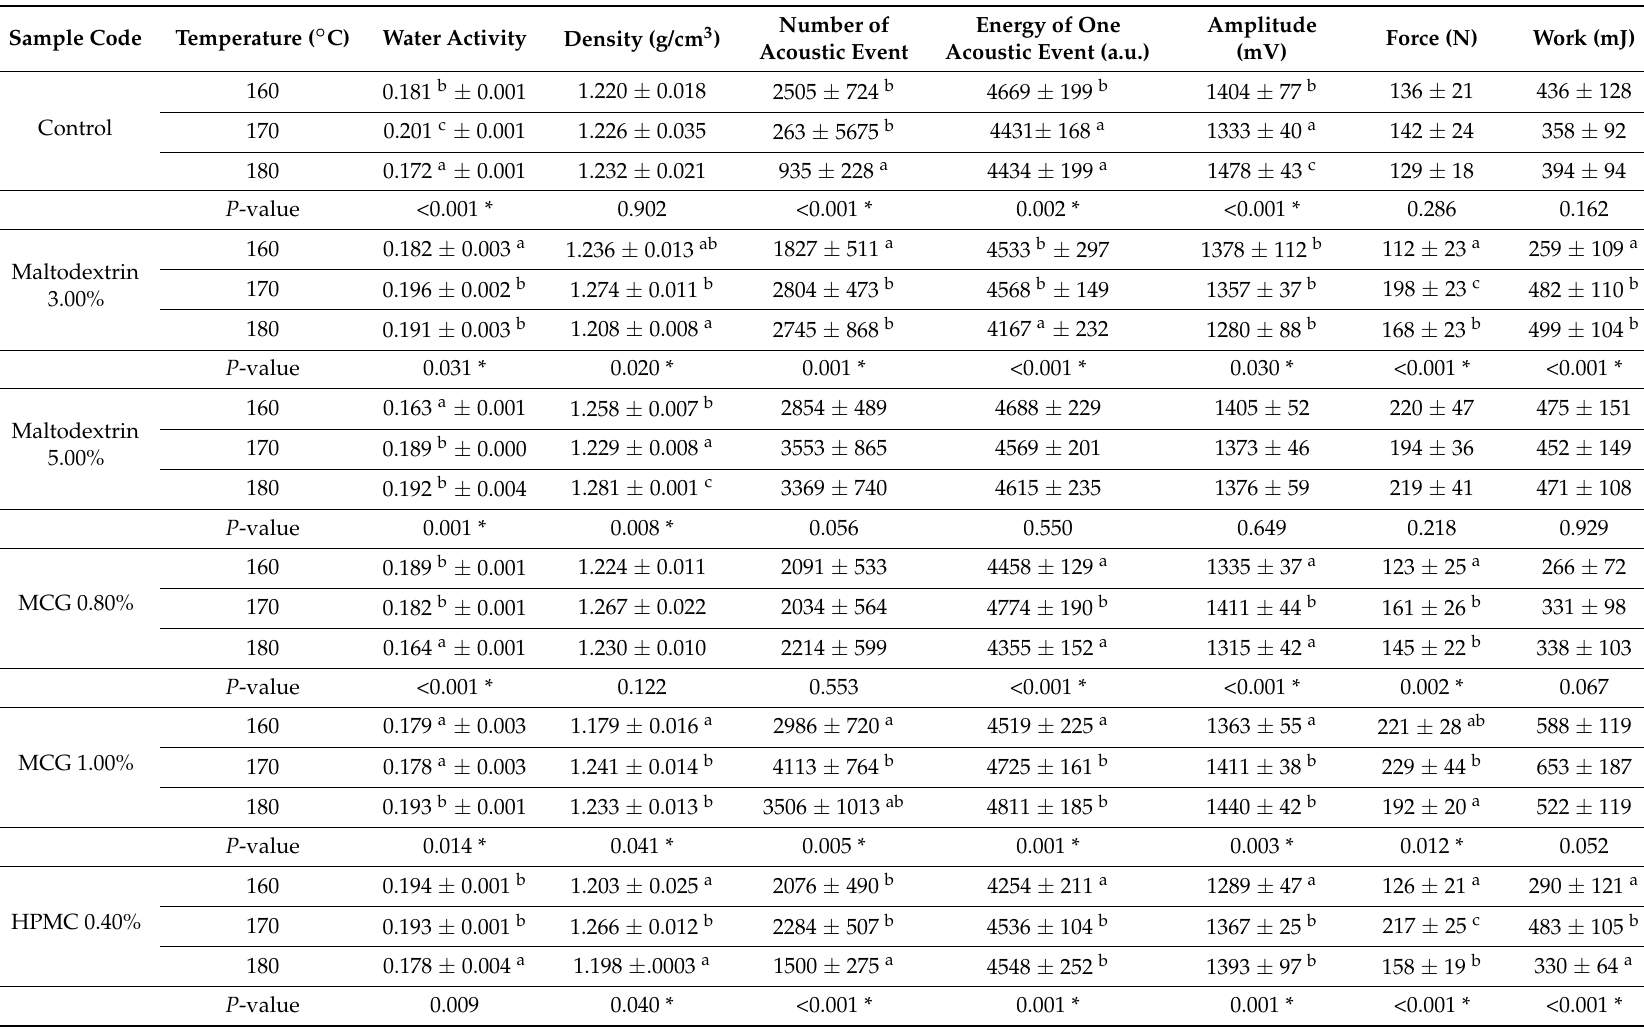
Table 3. The average values (with the standard deviations) of water activity, density, and texture parameters of the instant